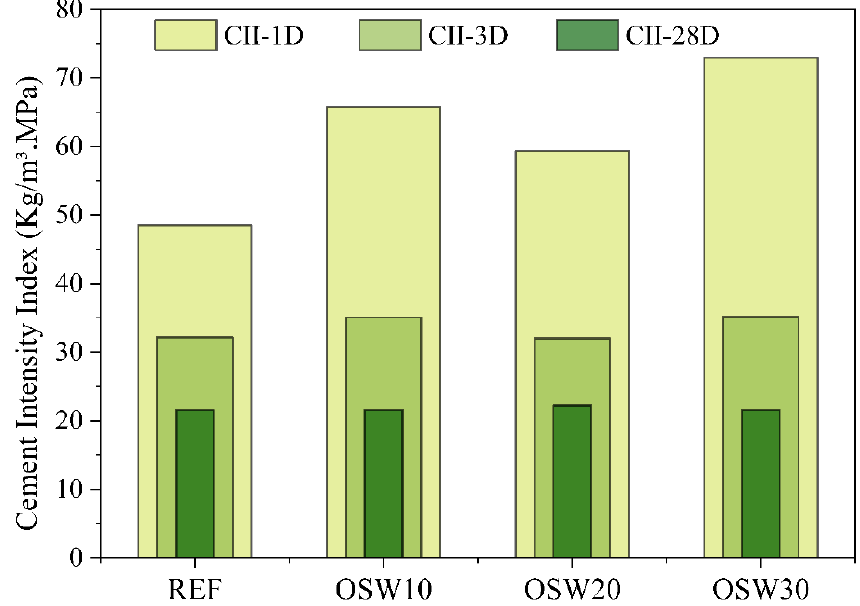
Figure 10. Cement intensity index of the cement pastes at 1, 3, and 28 days of age.